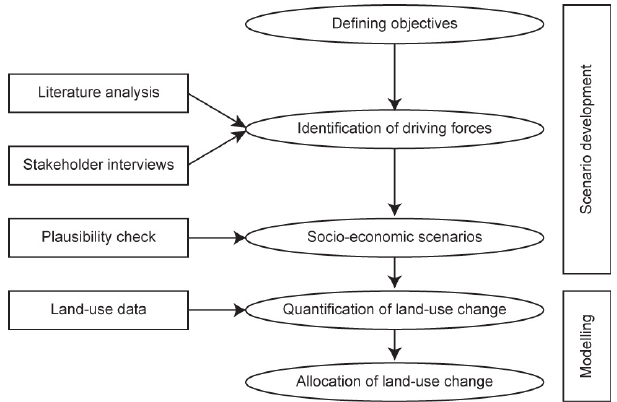
Figure 3. Procedure for generating